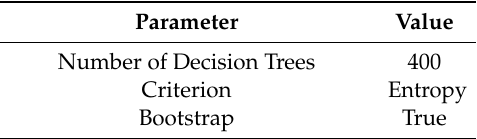
Table 2. Selected random forest classifier (RFC) parameters.